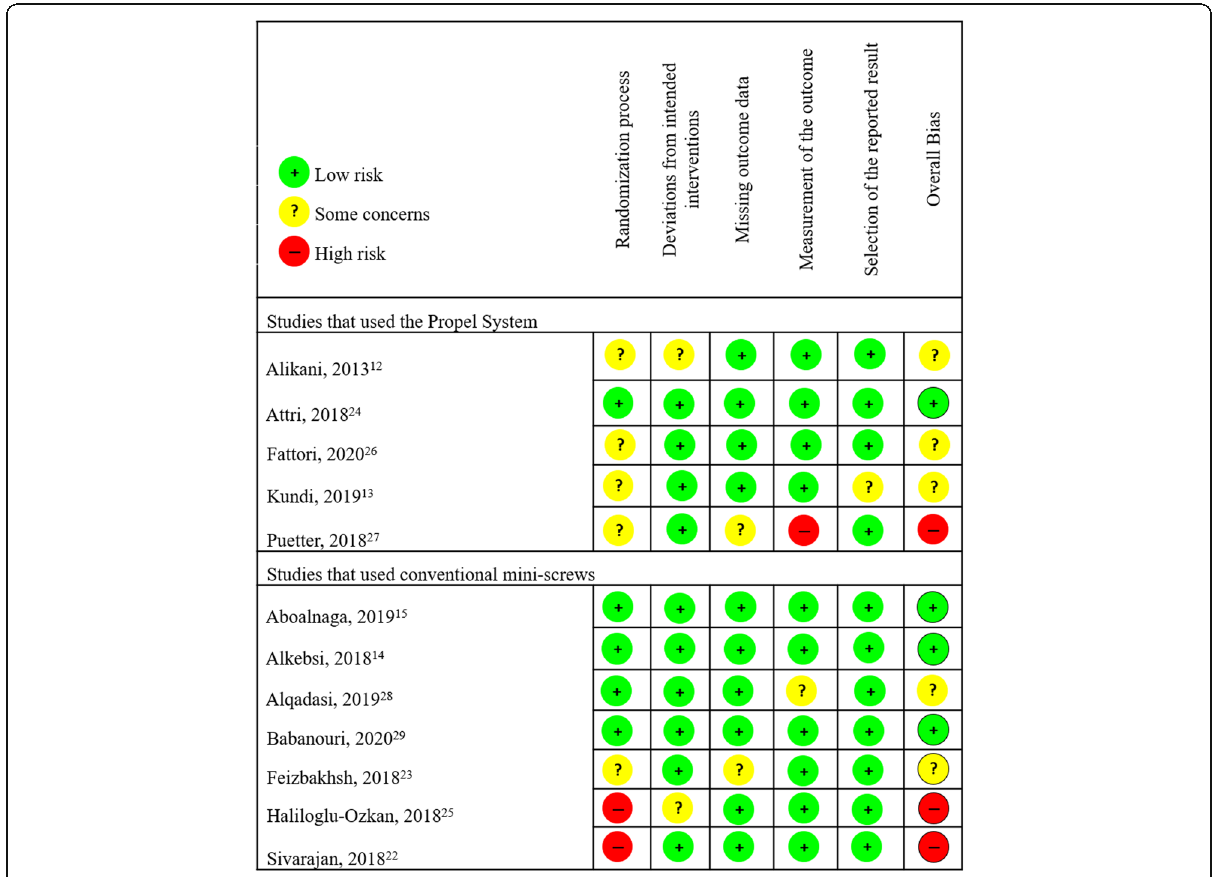
Fig. 2 Evaluation of included studies based on RoB assessment tool RoB